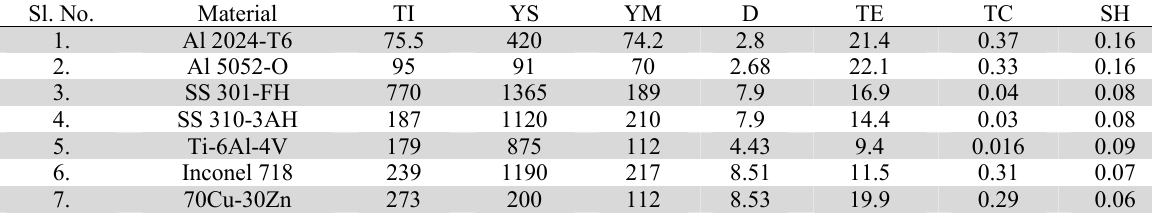
Data for cryogenic storage tank material selection problem (Manshadi et al., 2007) Sl.